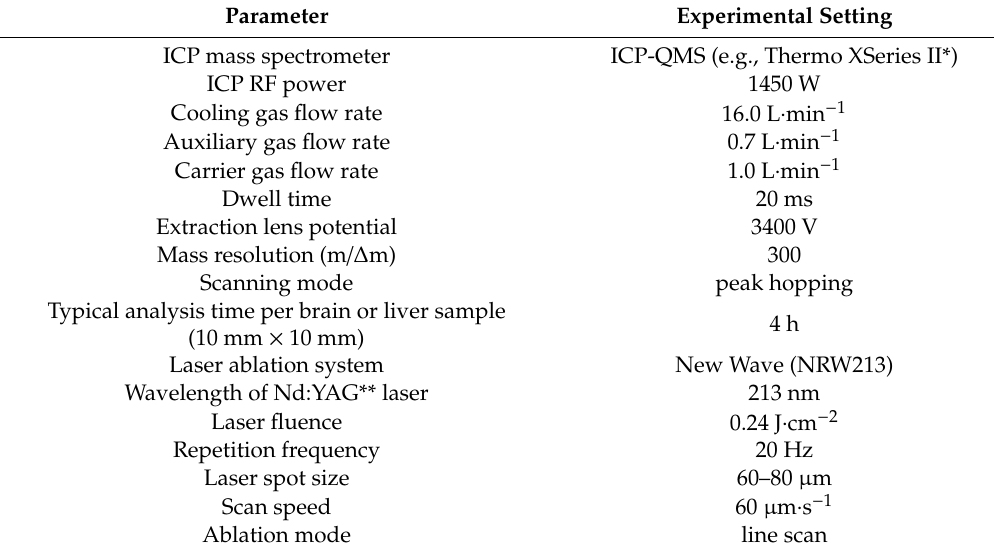
Table 2. Typical laser ablation inductively coupled plasma mass spectrometry (LA-ICP-MS) operating parameters for metal imaging in tissue